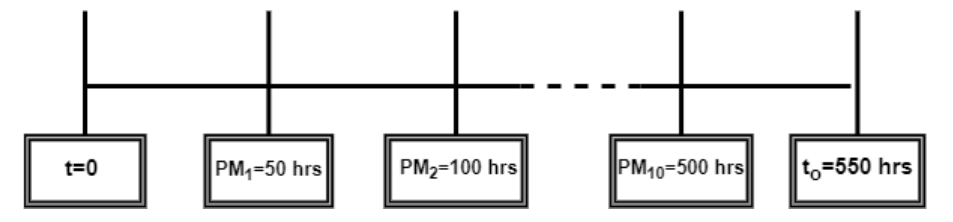
Figure 2. Present maintenance